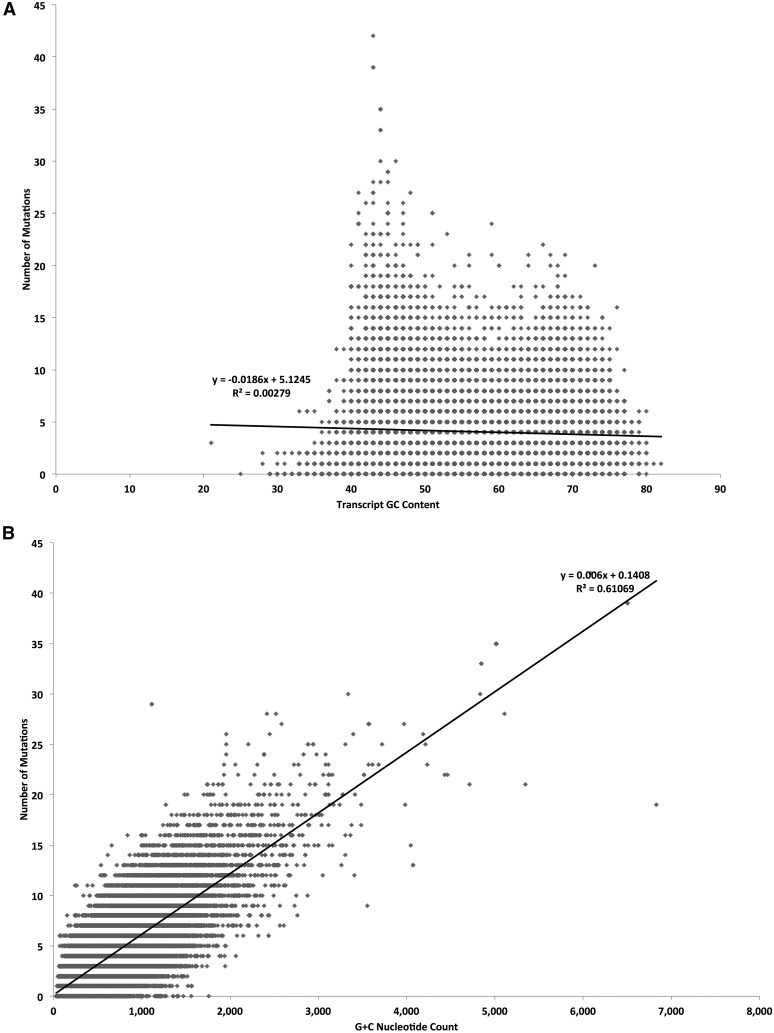
The examination of attributes that impact the number of predicted EMS-induced mutations in a gene transcript. (A) Scatterplot shows no direct linear correlation between mutation count and GC content. (B) Scatterplot depicting a linear correlation between mutation count and G+C count. (C) Linear correlation between mutation count and transcript sequence length.